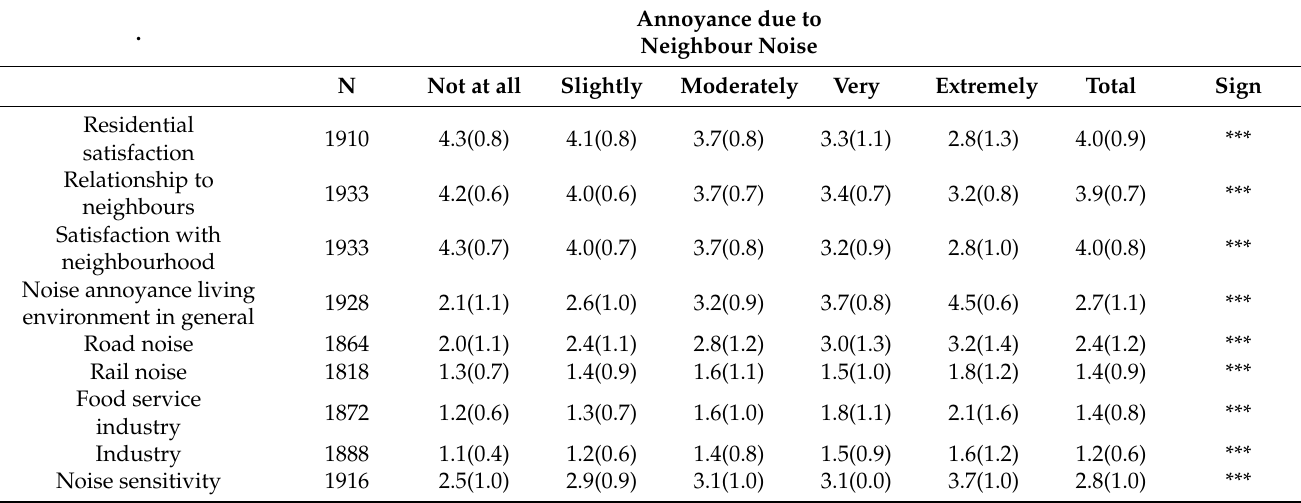
Table 2. Descriptions by annoyance levels (five-point verbal scale